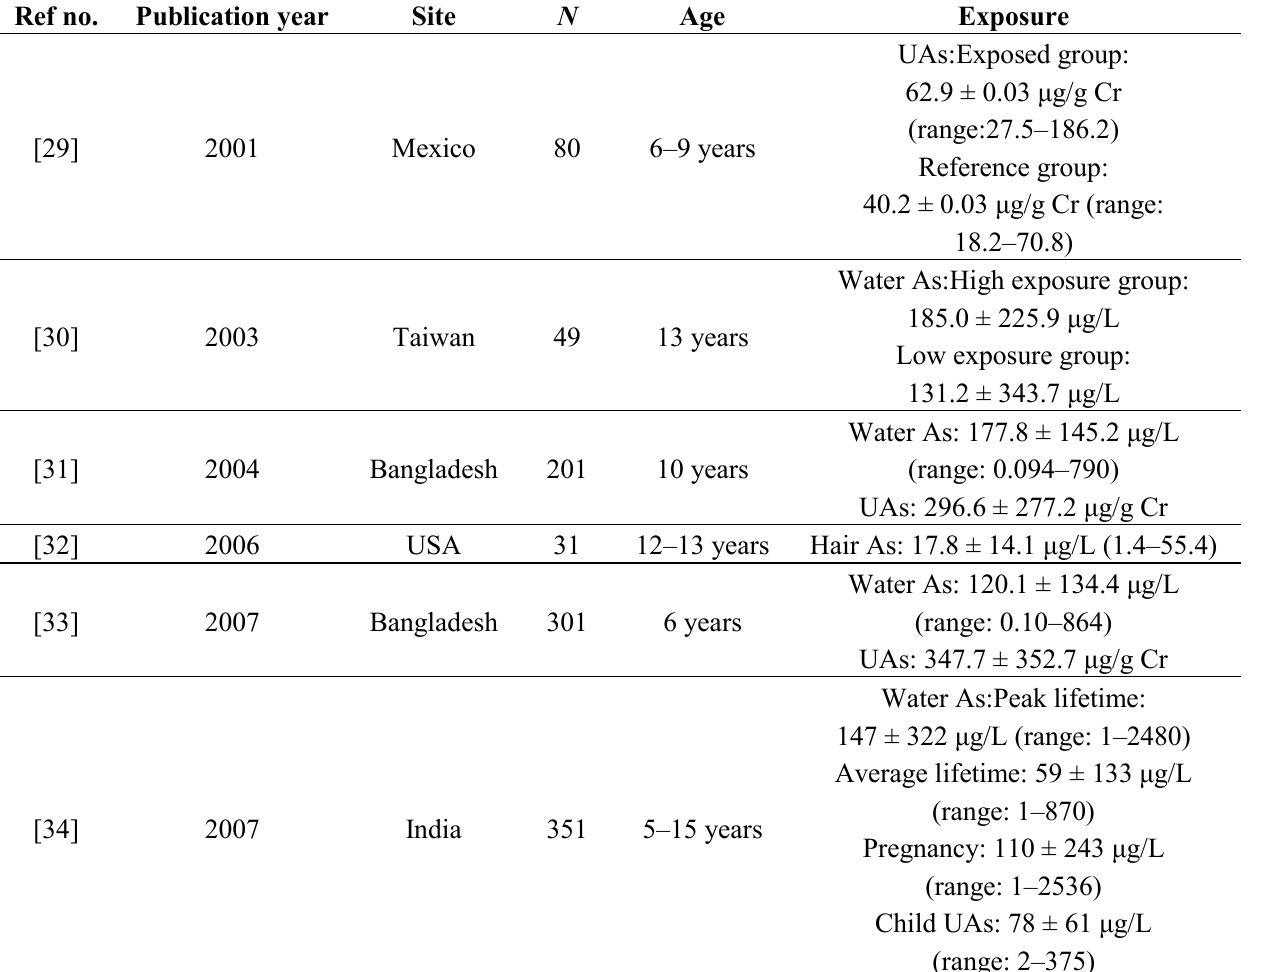
Table 1. Major epidemiological studies of neurodevelopmental toxicity of arsenic. Ref